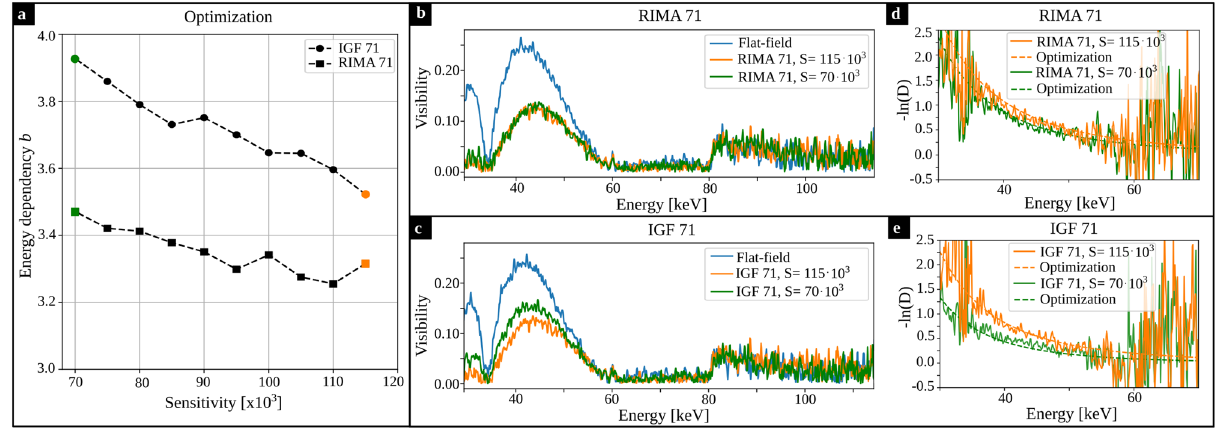
Figure 4. Spectrometer measurements. ( a ) The results from the optimization for all sensitivities investigated (RIMA 71 as squares and IGF 71 as circles). For both materials, the results for the lowest and highest sensitivity (green and orange) are compared to the spectrometer measurements. ( b , c ) Measured visibility spectra in 3 the flat-field (blue) and sample measurement for the lowest ( S = 70 · 10 ; green) and highest sensitivity 3 ( S = 115 · 10 ; orange) for RIMA 71 and IGF 71, respectively. d, e: The measured energy dependent dark-field signal is plotted for both sensitivities in solid lines. The results from the optimization (cf. Eqs. (1) and (5)) are plotted in dashed lines. They were factorized to take into account a sample thickness of 1 cm as used in the spectrometer